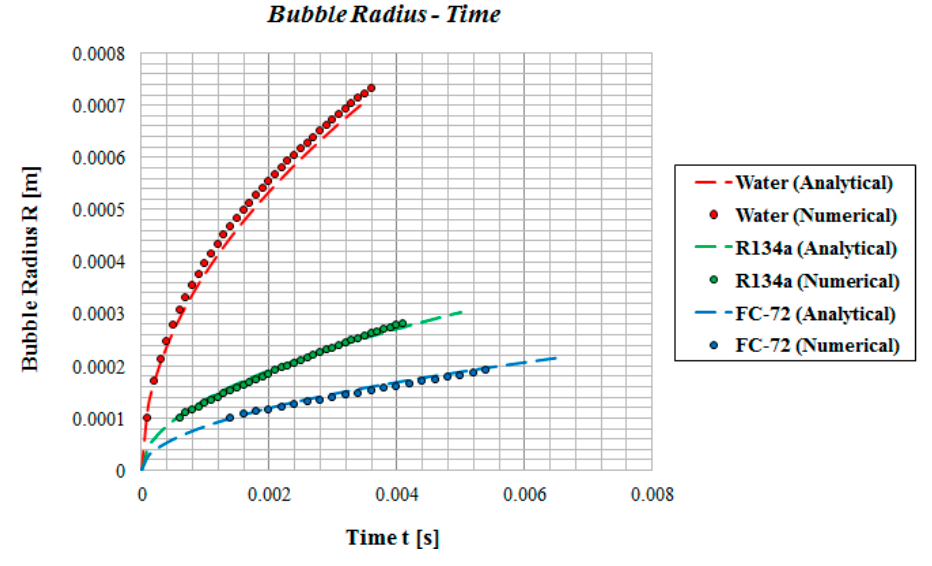
Figure 6. Bubble radius with respect to time for three different fluid cases. Comparison of numerical (present investigation) and analytical predictions [48].